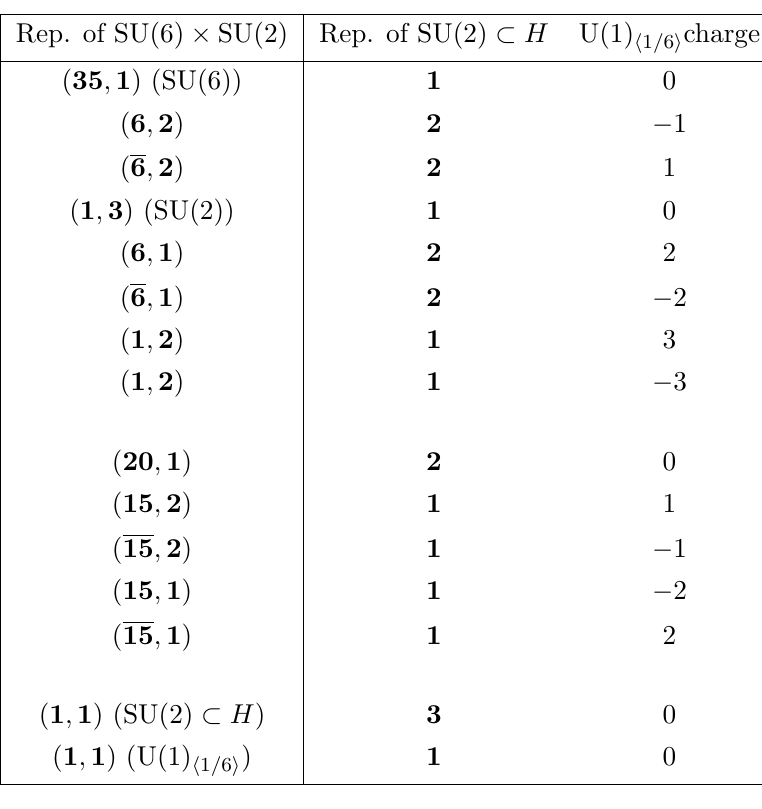
Table 17 . Decomposition of 248 .